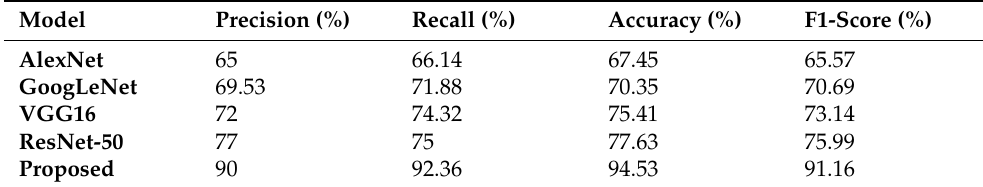
Table 4. Comparison of the presented approach with base techniques for the entire